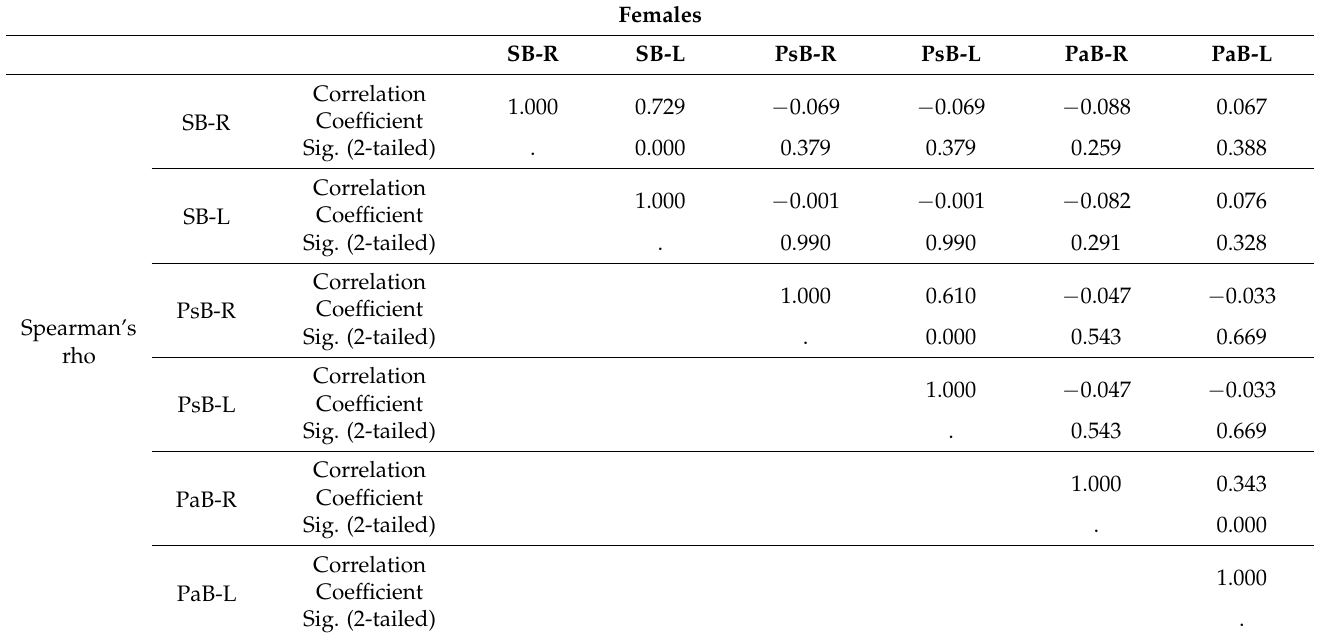
Table 5. Correlation between the different types of sphenoid bone bridges in the female